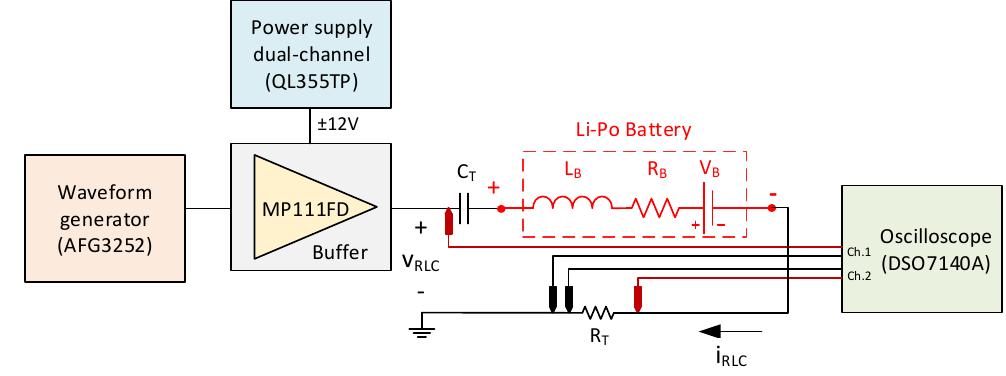
Figure 3. Experimental set-up to measure the battery stray